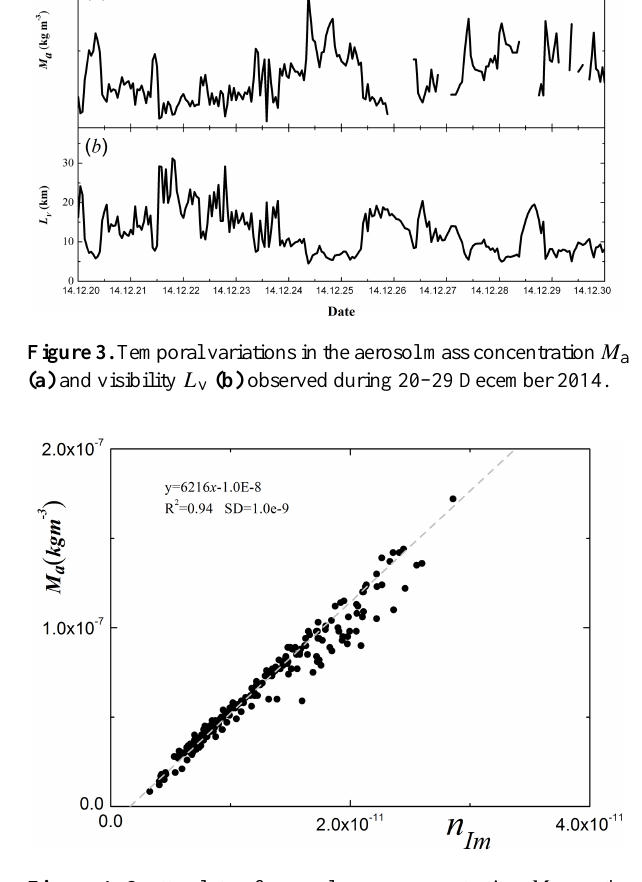
Figure 4. Scatterplots of aerosol mass concentration M a vs. the imaginary part of AERI calculated from Fig. 3b by Eq. (12).